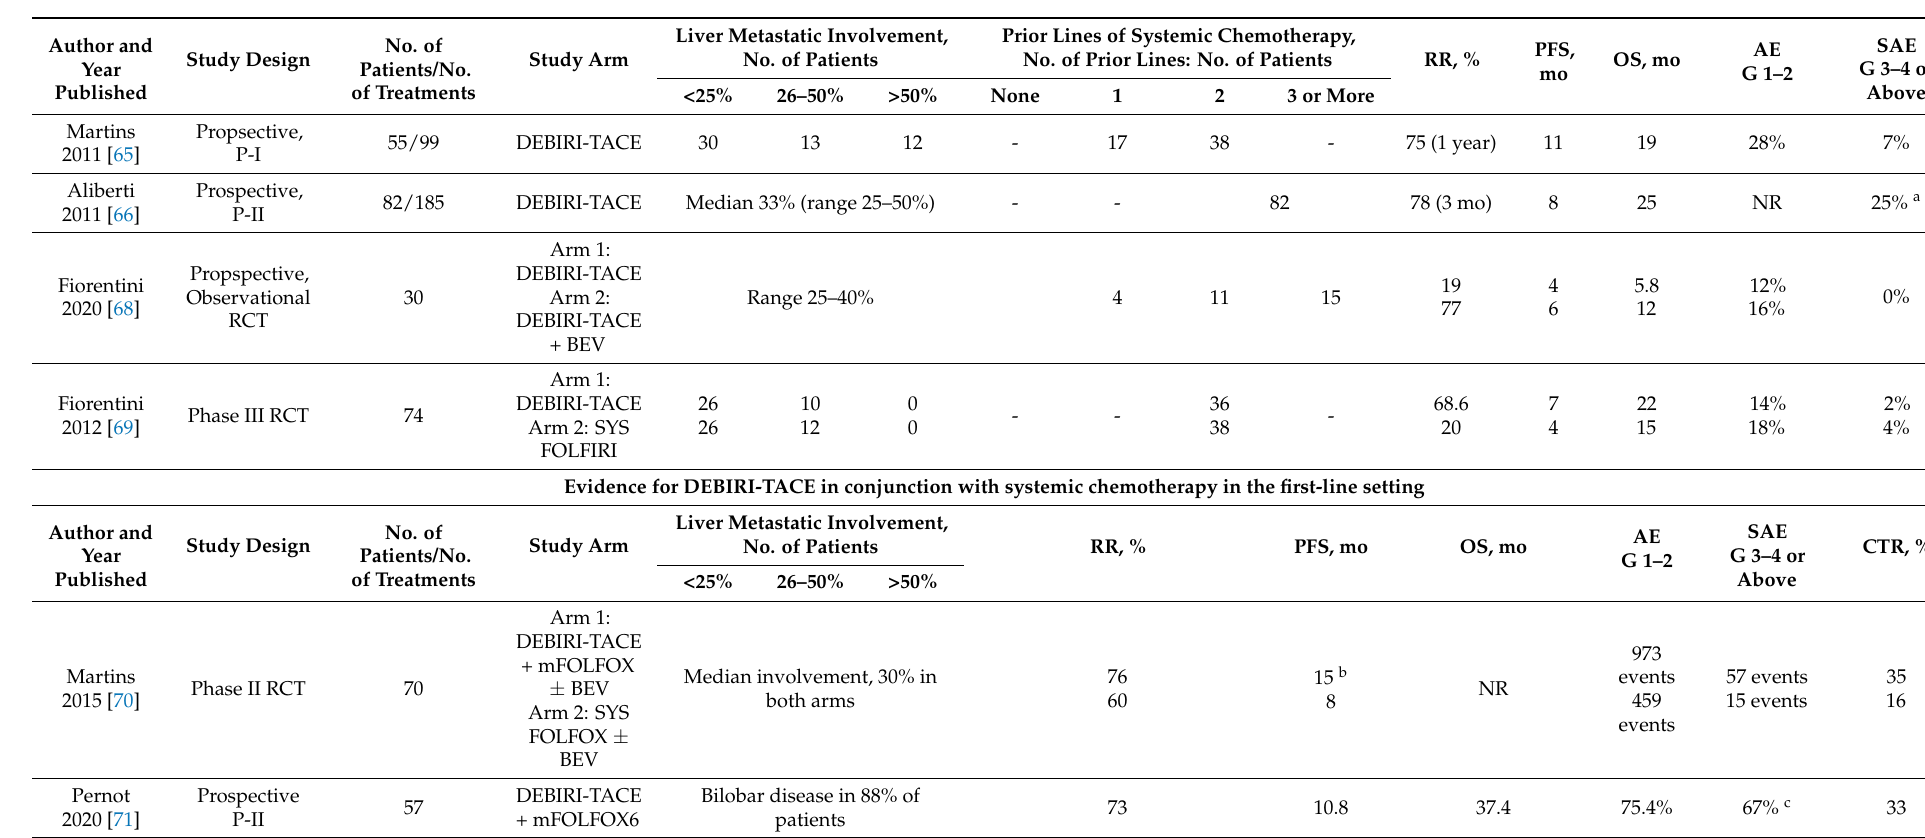
Table 2. Selected prospective trials for DEBIRI